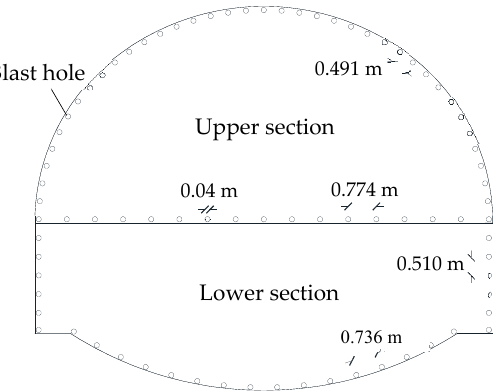
Figure 13. Layout drawing of blast holes.